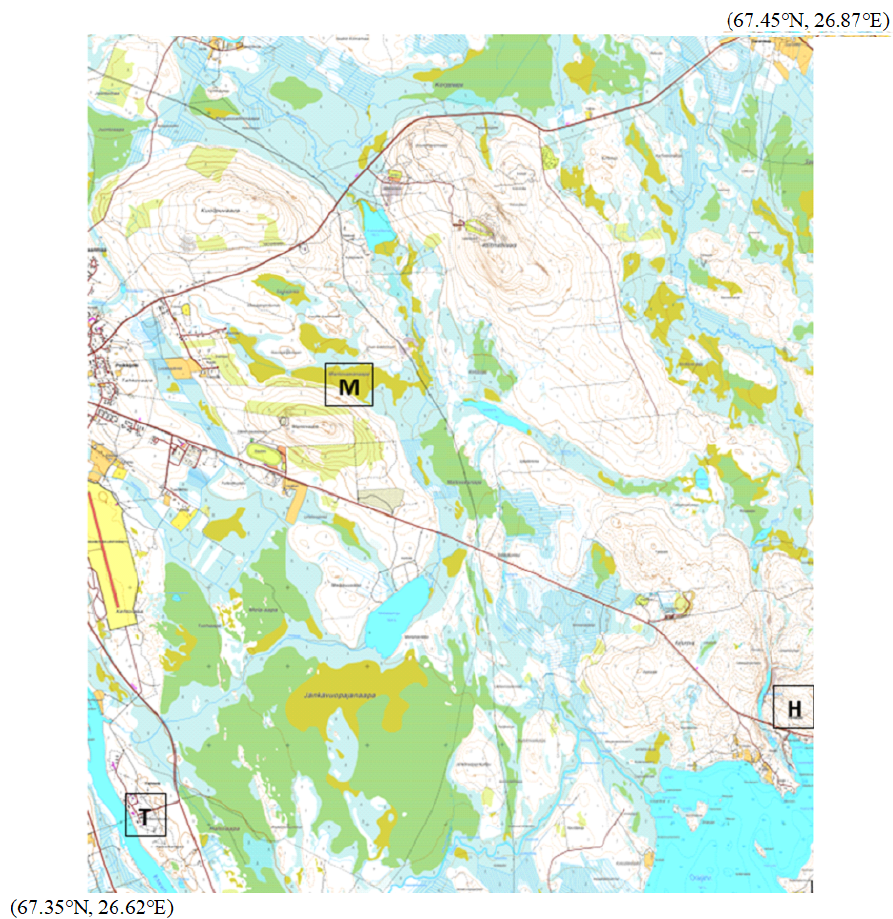
Figure 1. Test area in Sodankylä in northern Finland. The premises of the Arctic Space Centre of FMI are situated in Tähtelä (T). The operational albedo measurements are located in the upper part of the rectangle surrounding T and the NorSEN mast at the lower part. The aapa mire test site Mantovaaranaapa is marked with M and the forest clearing site Hirviäkuru with H. The corner coordinates of the area given in the WGS84 system. CC BY 4.0 National Land Survey of Finland (04/2020).